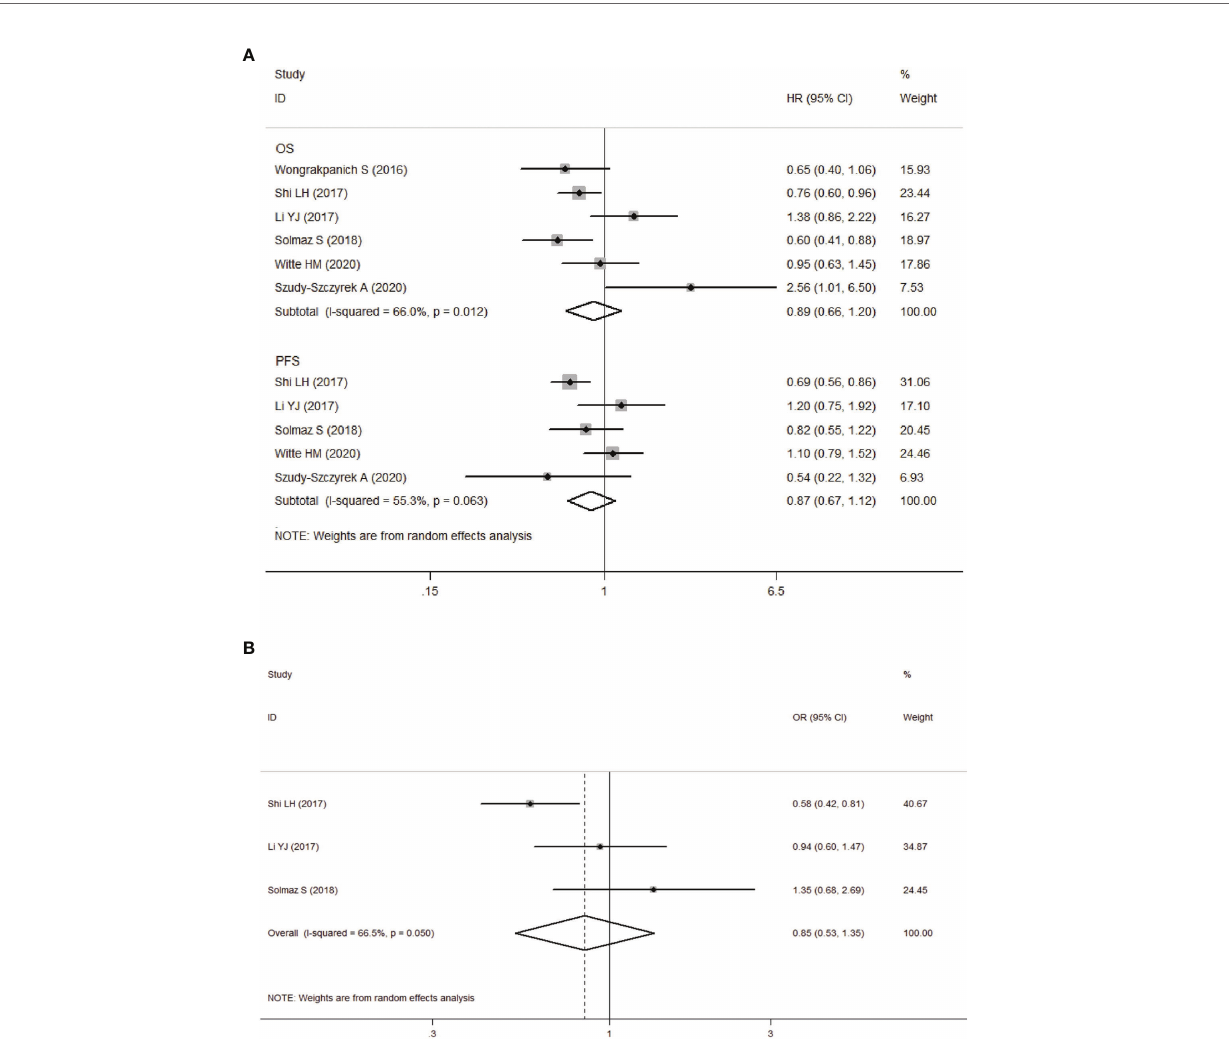
FIGURE 3 | (A) Forest plot for the association between platelet-to-lymphocyte ratio (PLR) and OS/PFS of patients with multiple myeloma (MM). (B) Forest plots of the association between PLR and ISS